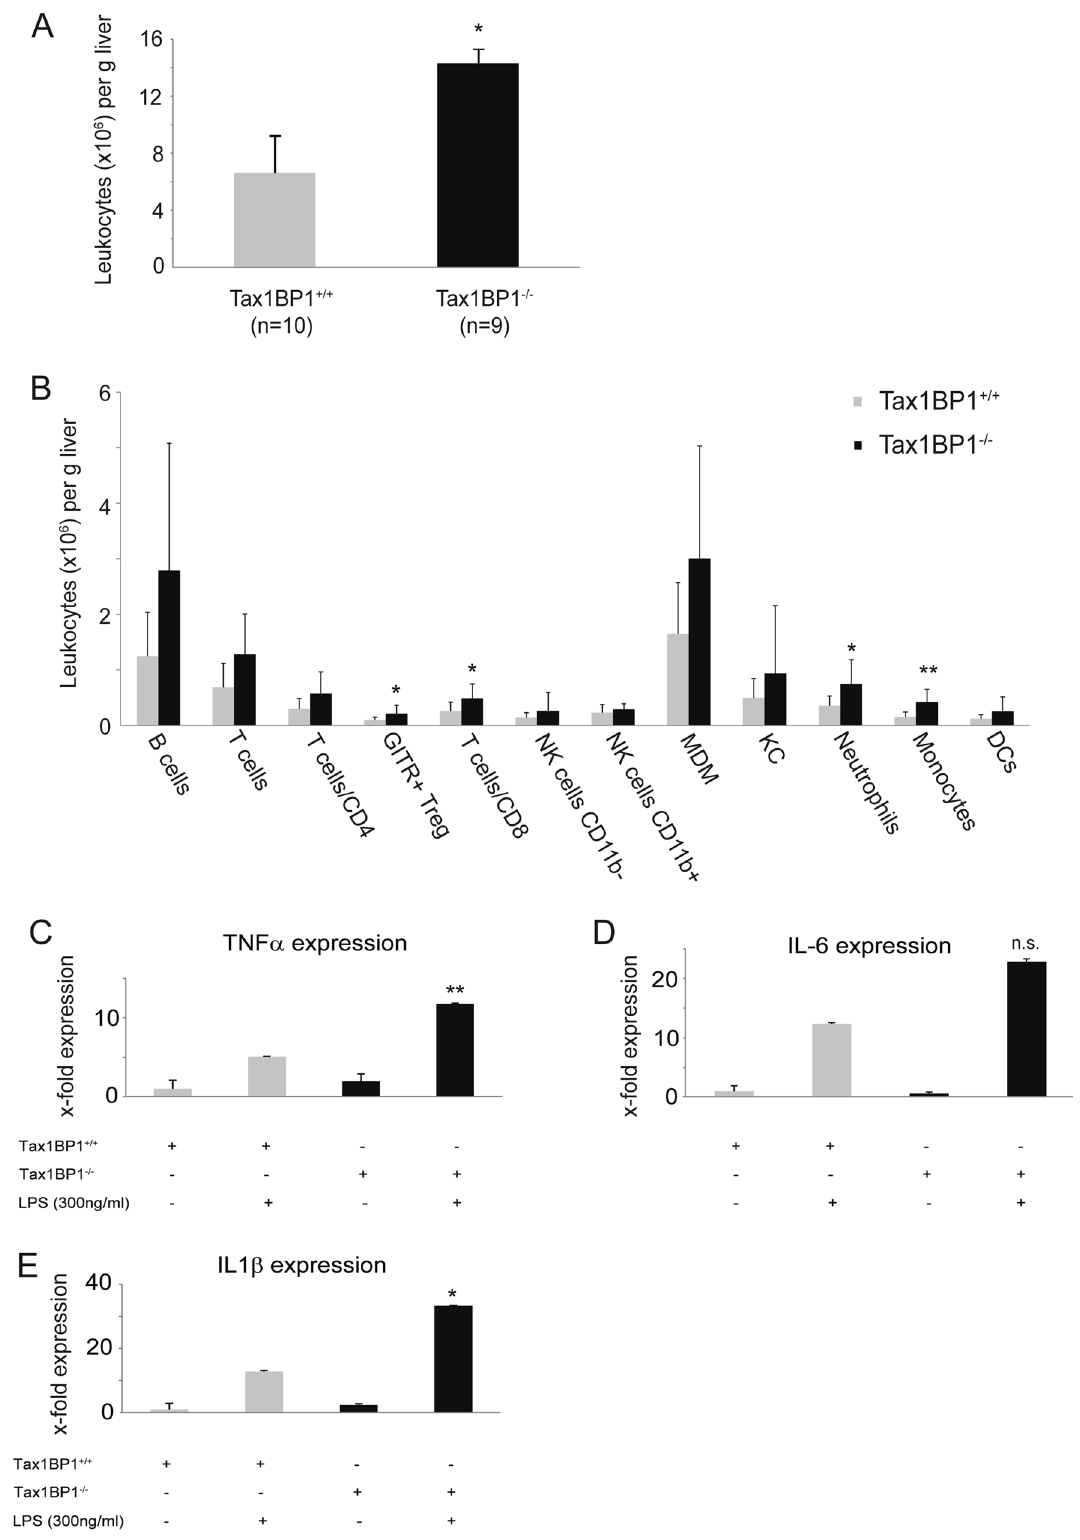
Figure 2. Increased number of leukocytes and increased inflammatory responses in Tax1BP1 −/− mice. Number of all leukocytes ( A ) and different subpopulations of leukocytes ( B ) were determined by FACS from livers of Tax1BP1 +/+ and Tax1BP1 −/− mice, respectively. mRNA of TNFα, IL-6 and IL1β was determined by quantitative PCR in Kupffer cells extracted from two livers of Tax1BP1 +/+ and Tax1BP1 −/− mice ± stimulation with LPS 300 ng/ml for 6 h. Relative expression of mRNA was normalized to unstimulated Tax1BP1 +/+ mice. Representative results of two independent experiments are shown ( C – E ). (* P < 0.05; ** P < 0.01; GITR glucocorticoid-induced tumor necrosis factor receptor related protein, NK cells natural killer cells, MDM monocyte-derived macrophages, KC Kupffer cells, DC dentritic